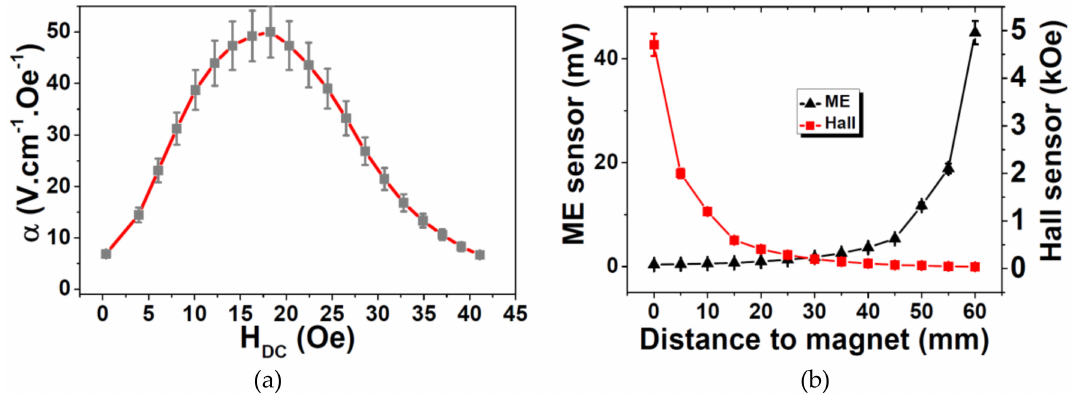
Figure 5. ( a ) ME voltage coe ffi cient ( α ) response as a function of the H DC . ( b ) ME sensor and Hall sensor response as a function of the distance to the